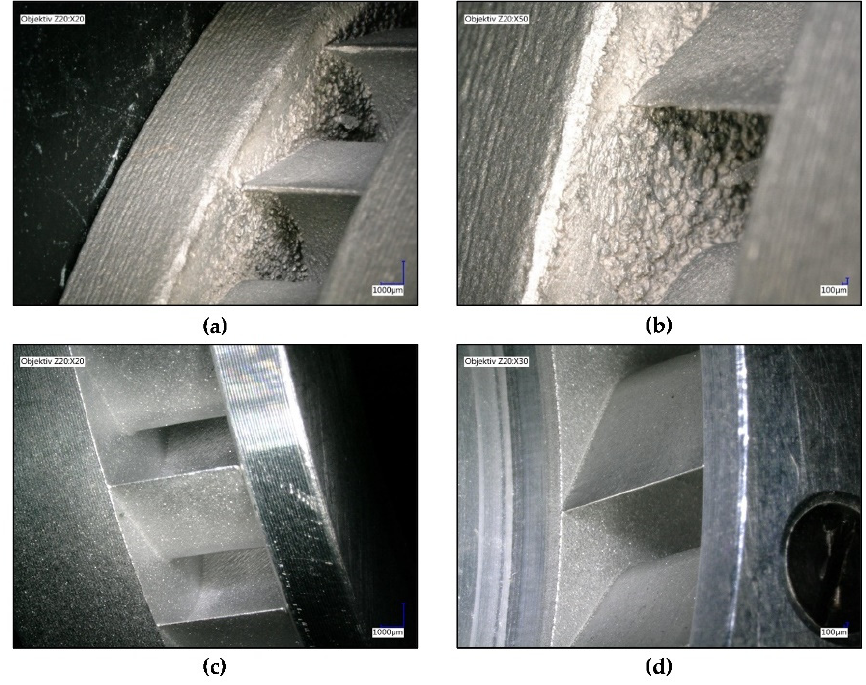
Figure 11. Surface texture of: ( a ) Printed rotor overview; ( b ) Printed rotor detailed view of flow channel; ( c ) Milled rotor overview; ( d ) Milled rotor detailed view of flow channel. Table 5. Surface roughness of the milled and the 3D printed wheel. Parameter